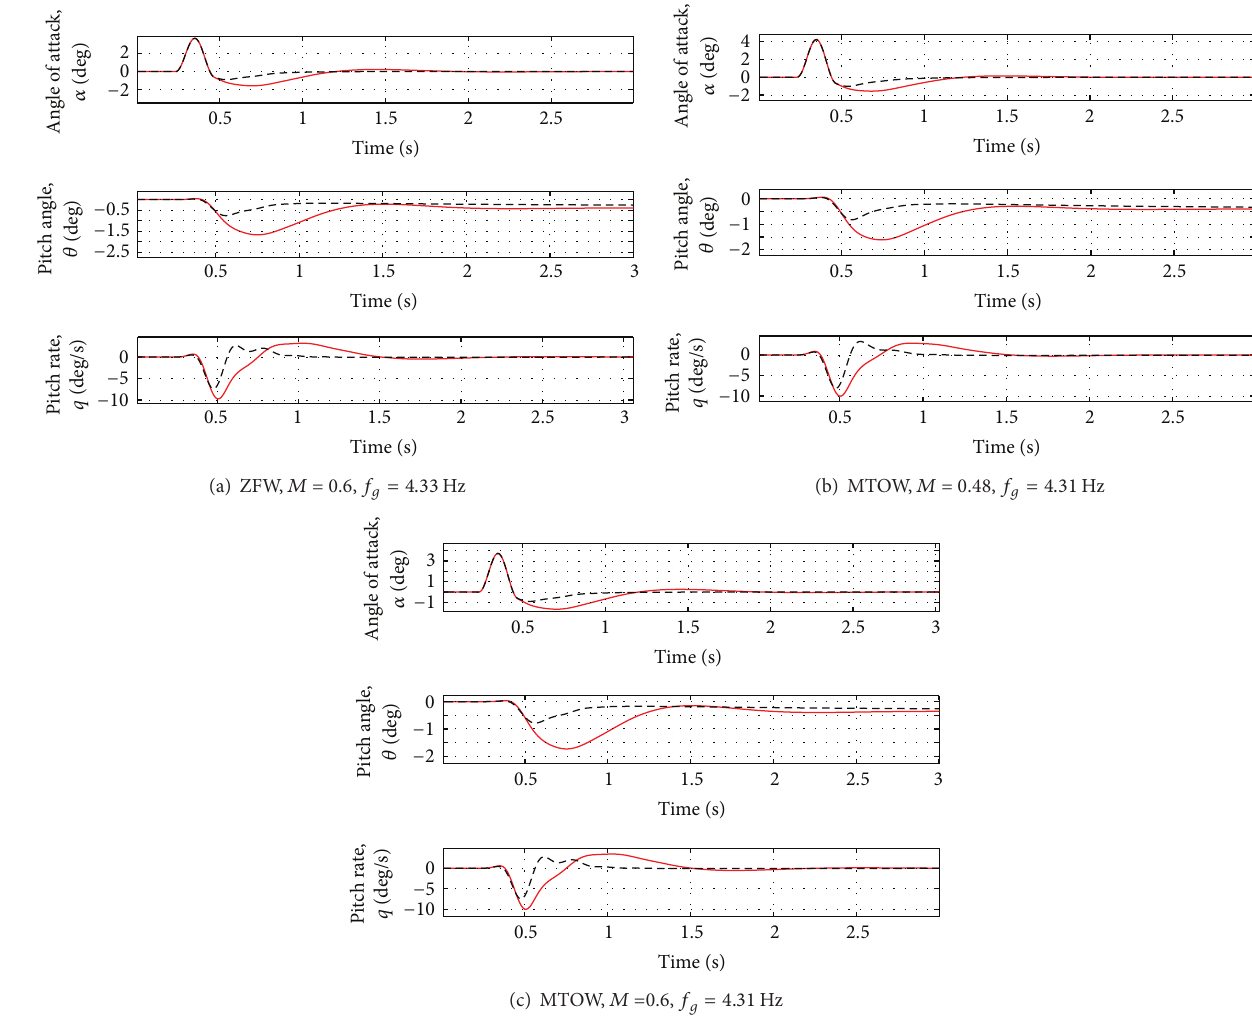
Figure 9: Rigid variable variation for all the cases in Table 3. Red solid line: open loop. Black dotted line: closed loop.